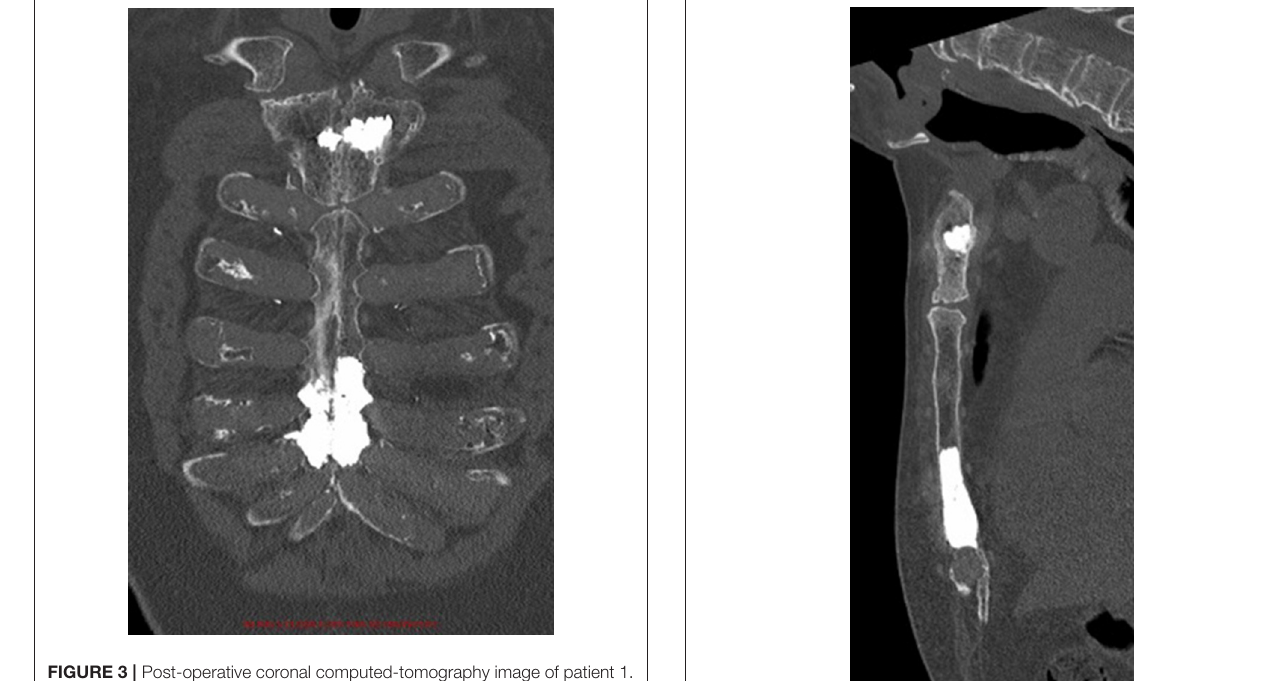
FIGURE 3 | Post-operative coronal computed-tomography image of patient 1.